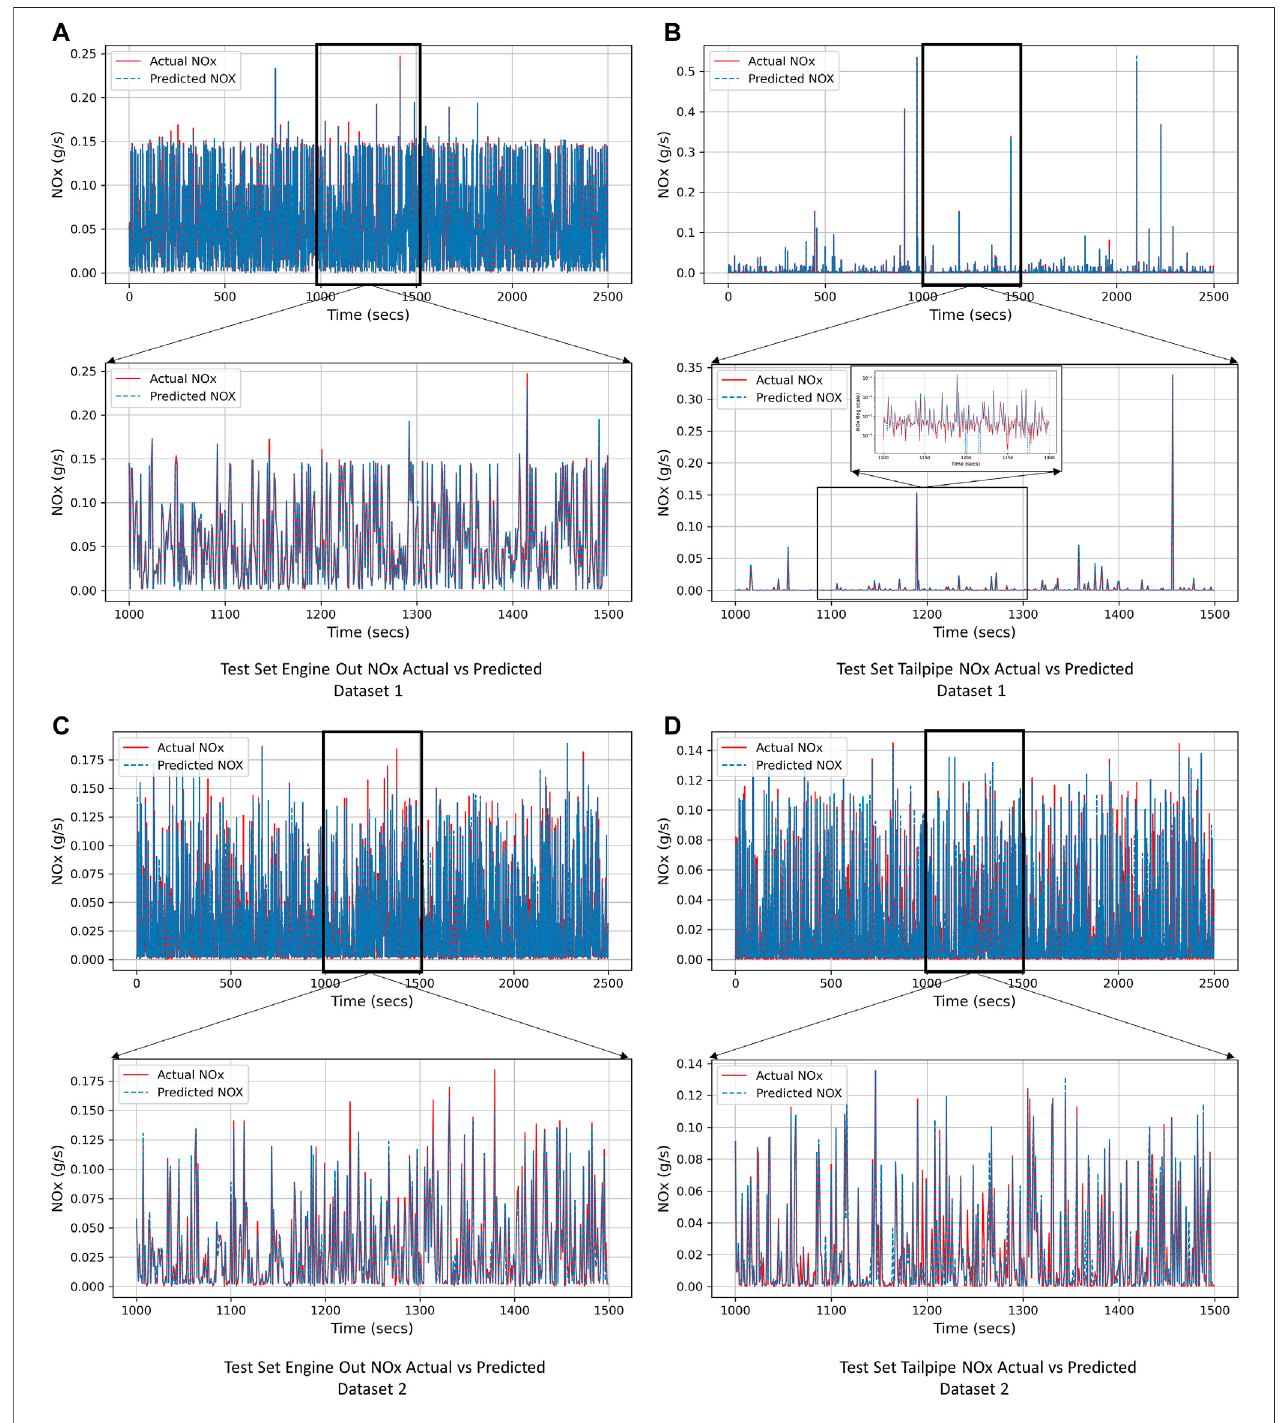
FIGURE 7 | Actual vs Predicted NO x emissions for a portion of the test set (All Models). (A) Test Set Engine Out NOx Actual vs Predicted Dataset 1. (B) Test Set Tailpipe NOx Actual vs Predicted Dataset 1. (C) Test Set Engine Out NOx Actual vs Predicted Dataset 2. (D) Test Set Tailpipe NOx Actual vs Predicted Dataset 2.